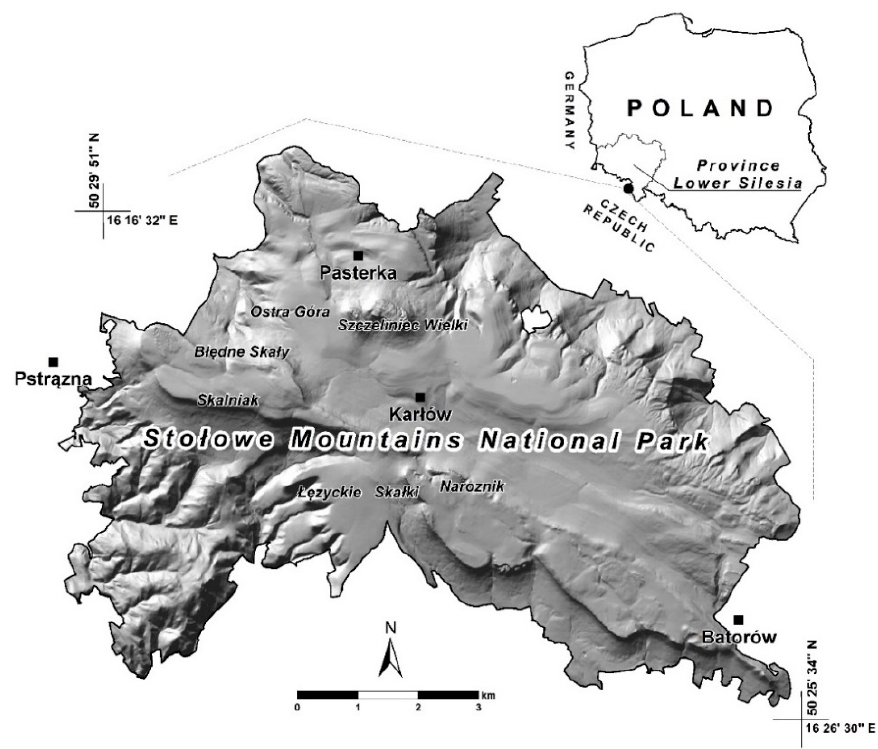
Figure 1. Location of the study area on a digital elevation model (DEM) map. DEM data acquired from light detection and ranging (LIDAR) [56].